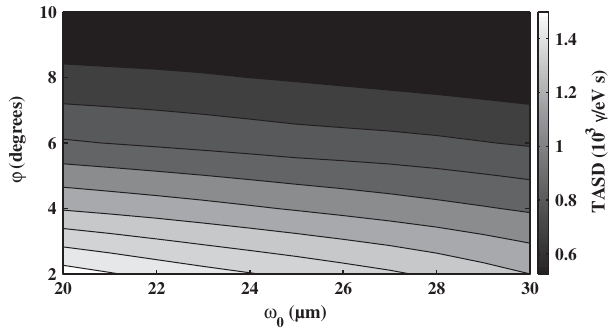
FIG. 6. TASD results for one recirculation pass. The region of interest is the light gray region.